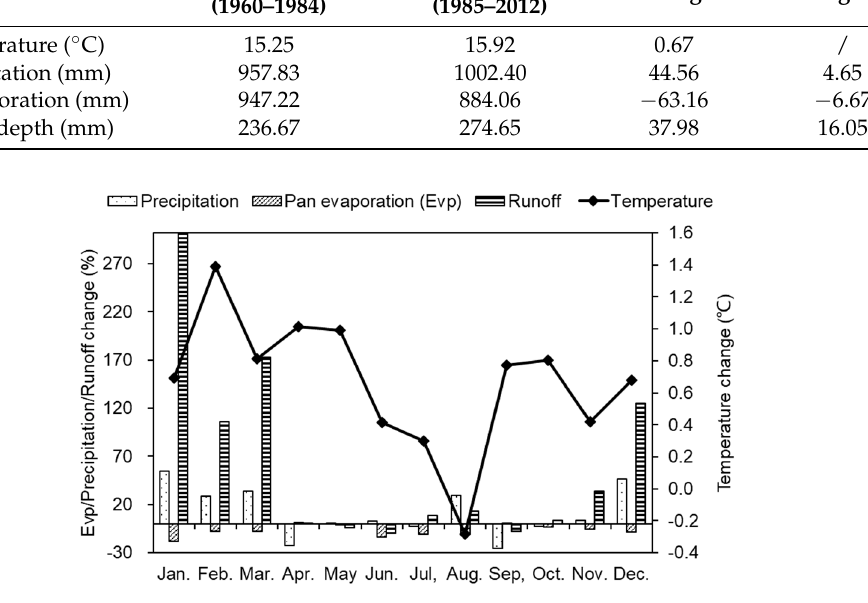
Figure 5. Intra-annual variations of meteorological variables during the disturbed period (1985–2012) relative to the baseline period (1960–1984) for the Qingliu River basin, East China.